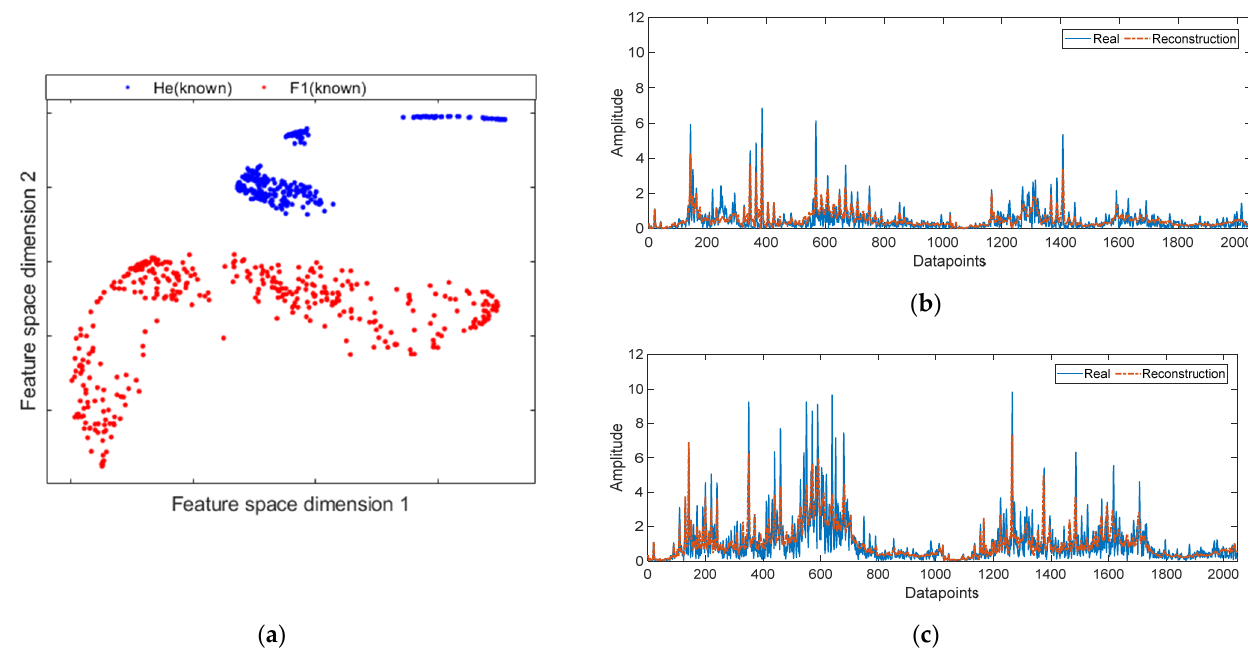
Figure 5. Characterization of the healthy condition and a fault condition by mean DAE: ( a ) feature space mapping of the bottleneck obtained through a traditional DAE; ( b ) real and reconstructed healthy condition signal; ( c ) real and reconstructed signal of a fault condition.